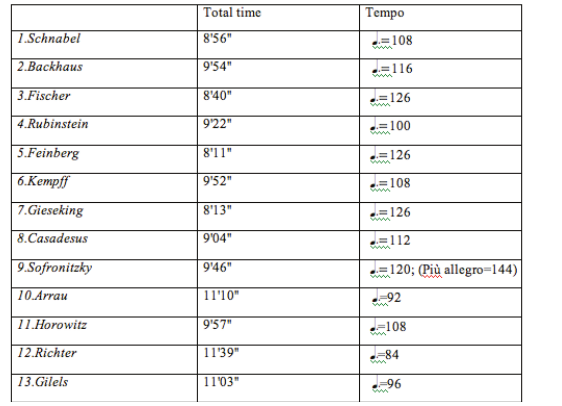
Table 2 . Beethoven, Sonata op. 57. Appassionata,